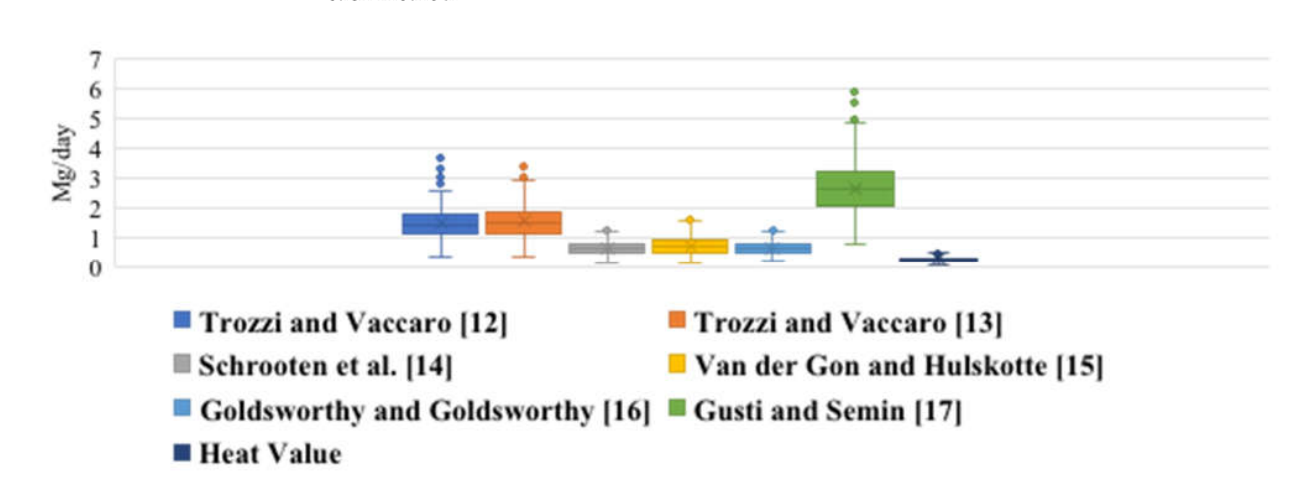
Figure 6. Boxplot of atmospheric emissions (Mg/day) for each method. Table 9. Correlation Coefficient (R 2 ) according to Pearson